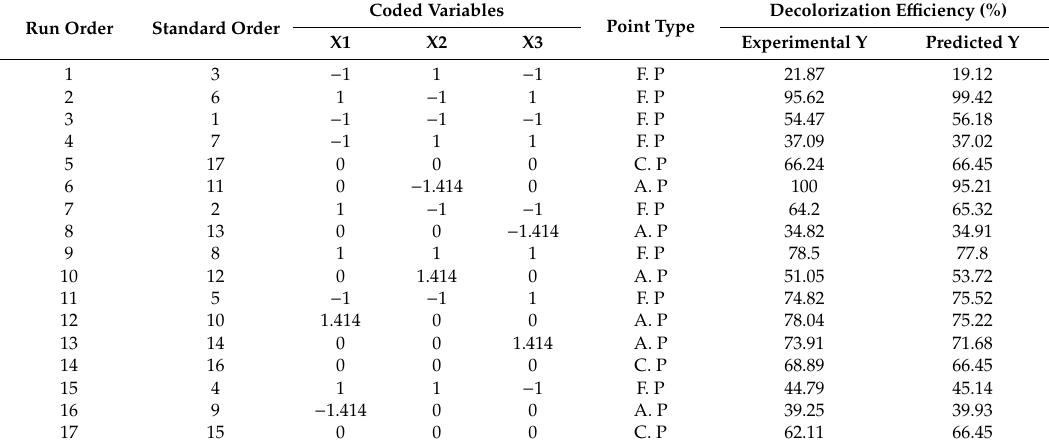
Table 4. Central composite design (CCD) design matrix of experiments and their